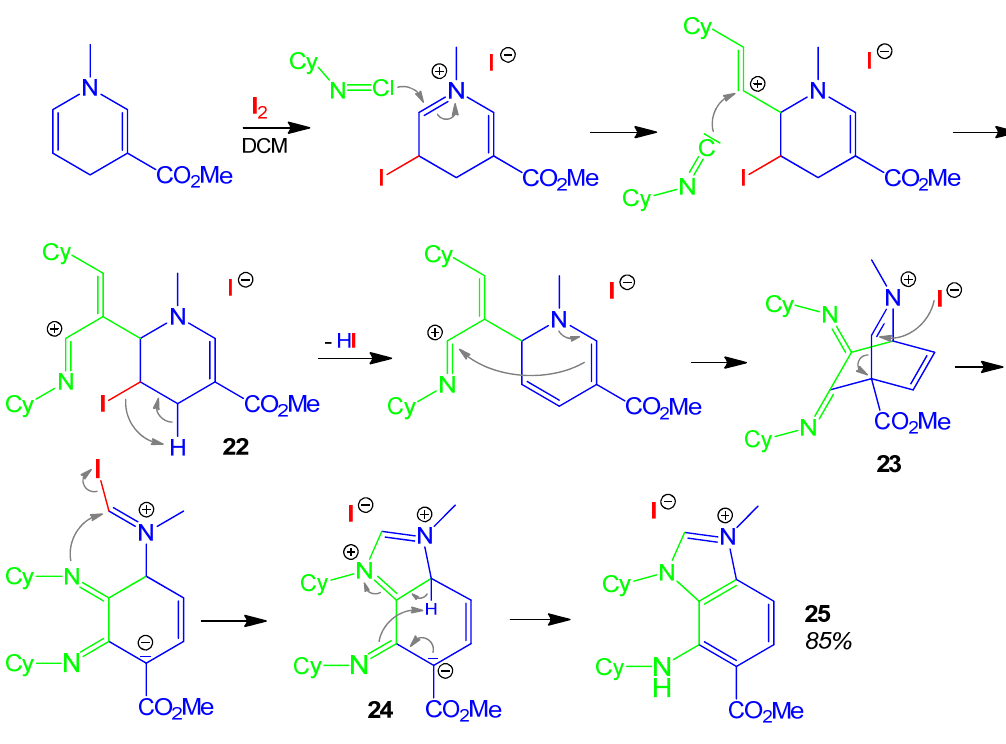
Scheme 13. Synthesis of imidazolium salt 25 by